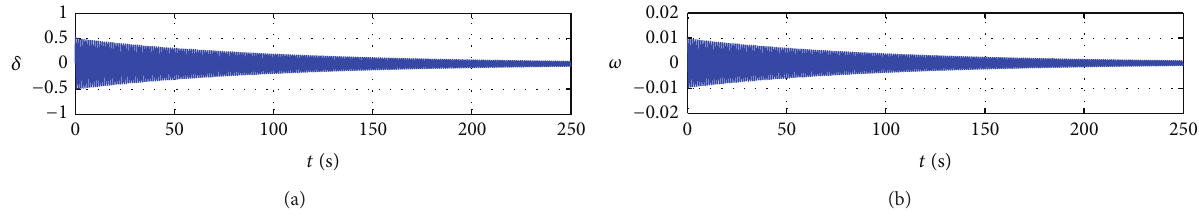
Figure 6: Time waveforms of 𝛿 and 𝜔 with 𝐾 𝑖 = 1 , 𝐾 𝑝 = 2 , 𝐾 𝑑 = 0.6 .